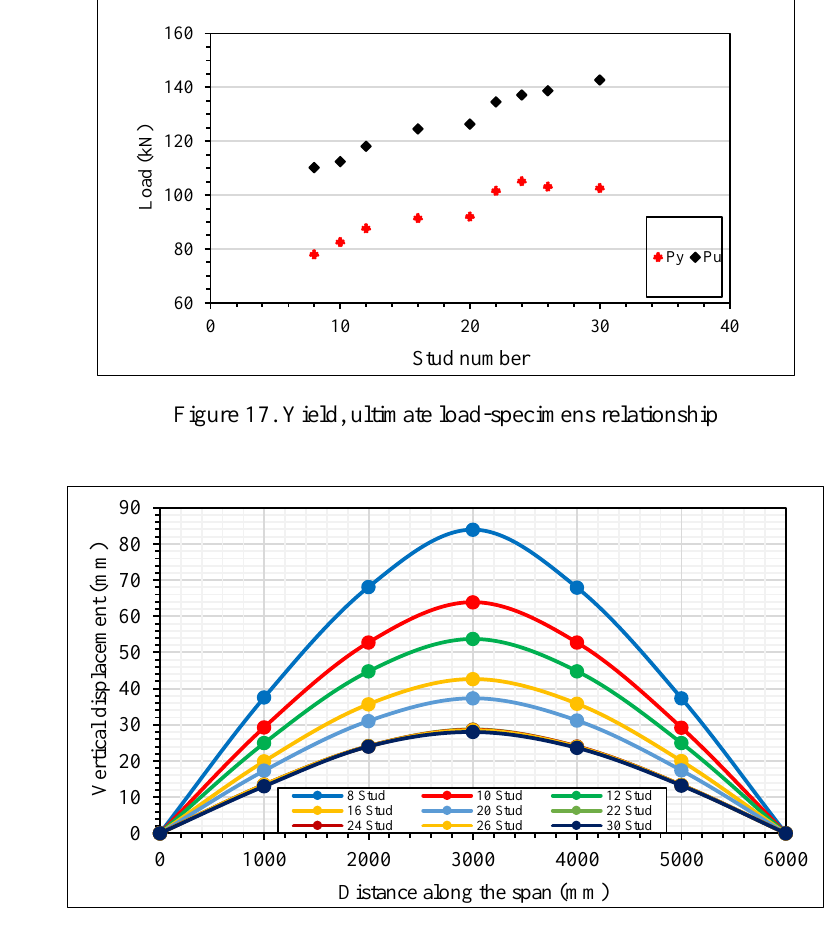
Figure 18. Deflection profile for the curved composite beam at 100 kN loading level